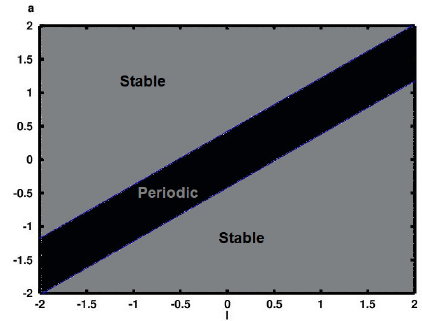
Figure 44. Two-parameter bifurcation of pa- rameter b concerning the external applied cur- rent with parameters a = 0.8 , b = 0.7 & c = 3 . Sta- ble state is shown by grey shaded region) and unstable by black shaded region